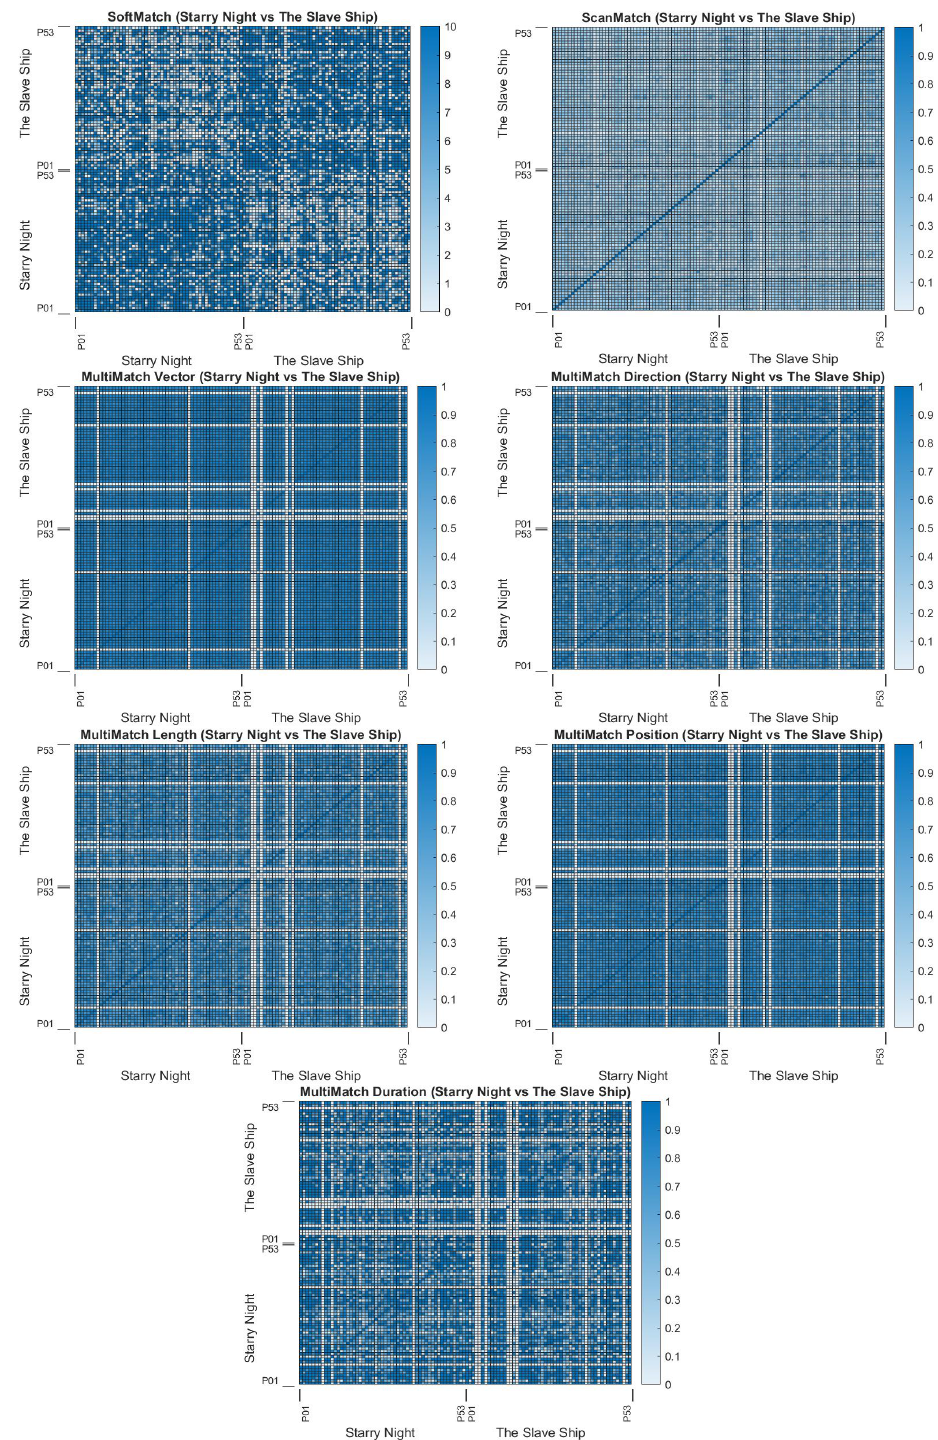
Figure A15. SoftMatch, ScanMatch, and MultiMatch heatmaps for empirical evaluation. Stimuli matched are Vincent van Gogh’s Starry Night (1889) and William Turner’s The Slave Ship